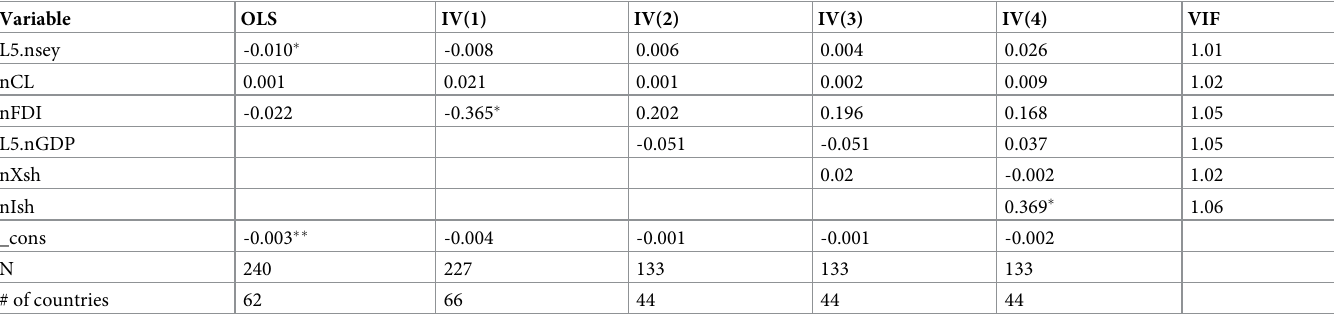
Table 9 below lists the replication results of LSZ [2] with our quasi-cross-sectional data. All of the significant results in Table 8 have now disappeared or reduced, and the effect of investment Table 9. Replication of LSZ [2] with quasi-cross-sectional data.